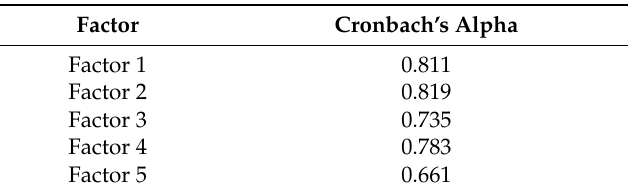
Table 3. Cronbach’s alpha